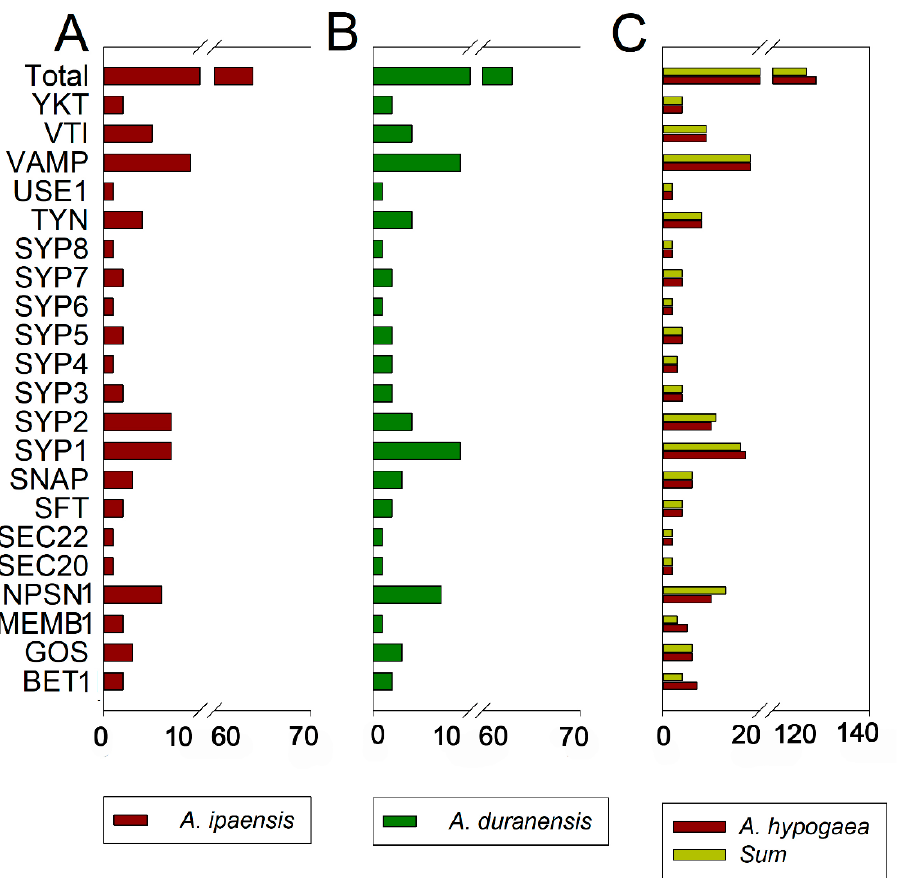
Figure 2. Number of SNARE genes identified per SNARE-type subfamily. ( A ) A. ipaensis ; ( B ) A. duranensis ; ( C ) A. hypogaea . The sum of genes in A. ipaensis and A. duranensis (green–yellow) is also shown ( C ).